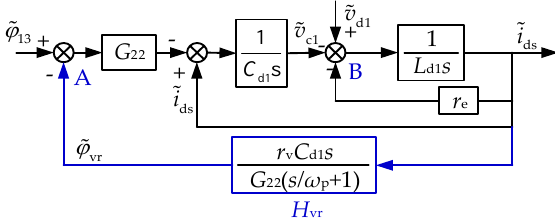
Figure 3. Schematic diagram of virtual damping implementation.